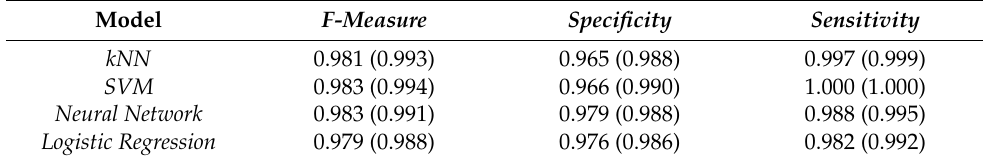
Table 1. Lung disease detection classification results.